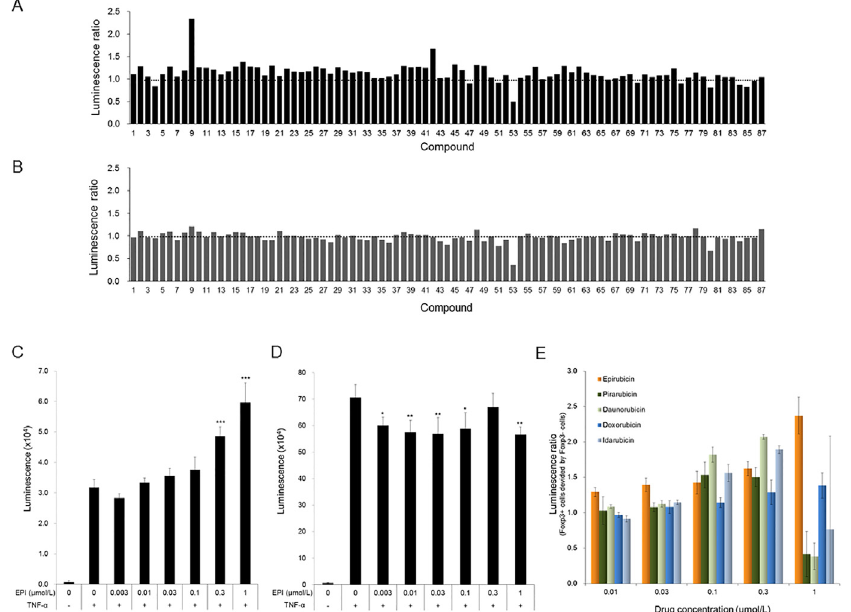
Fig 2. Epirubicin (EPI) represses the inhibitory effect of Foxp3 on the activity of NF- κ B. (A) HEK293/ NF- κ B-RE/Foxp3 cells. (B) HEK293/NF- κ B-RE cells. About 90 compounds were screened in duplicate. The cells were pretreated with each compound (1 μ mol/L) for 1h and then stimulated with 0.3 ng/mL TNF- α for 2.5h, followed by detection of NF- κ B-dependent luciferase activity. Normalized activity is expressed as the fold difference relative to the control activity (stimulated cells pretreated with DMSO). Each column represents the mean (n = 2). Compound 9 and 53 indicate epirubicin and digoxin, respectively. (C) HEK293/ NF- κ B-RE/Foxp3 cells. (D) HEK293/NF- κ B-RE cells. The cells were pretreated for 1 h with epirubicin (EPI, 0.003 – 1 μ mol/L) and then stimulated with 0.3 ng/mL TNF- α for 2.5 h, followed by detection of NF- κ B- dependent luciferase activity. Each column represents the mean ± SD (n = 3). Asterisks represent statistically significant differences from DMSO-treated control as determined by Dunnett ’ s test ( * , p < 0.05; ** , p < 0.01; *** , p < 0.001). (E) HEK293/NF- κ B-RE/Foxp3 or HEK293/NF- κ B-RE cells were pretreated for 1 h with the indicated drug (0.01 – 1 μ mol/L) and then stimulated with 0.3 ng/mL TNF- α for 2.5 h, followed by detection of NF- κ B-dependent luciferase activity. After calculating normalized activity relative to the control (stimulated cells pretreated with DMSO) in each cell line, the luminescence ratio in HEK293/NF- κ B-RE/Foxp3 cells (Foxp3+ cells) was divided by that in HEK293/NF- κ B-RE cells (Foxp3- cells). Each column represents the mean ± SD (n = 3).